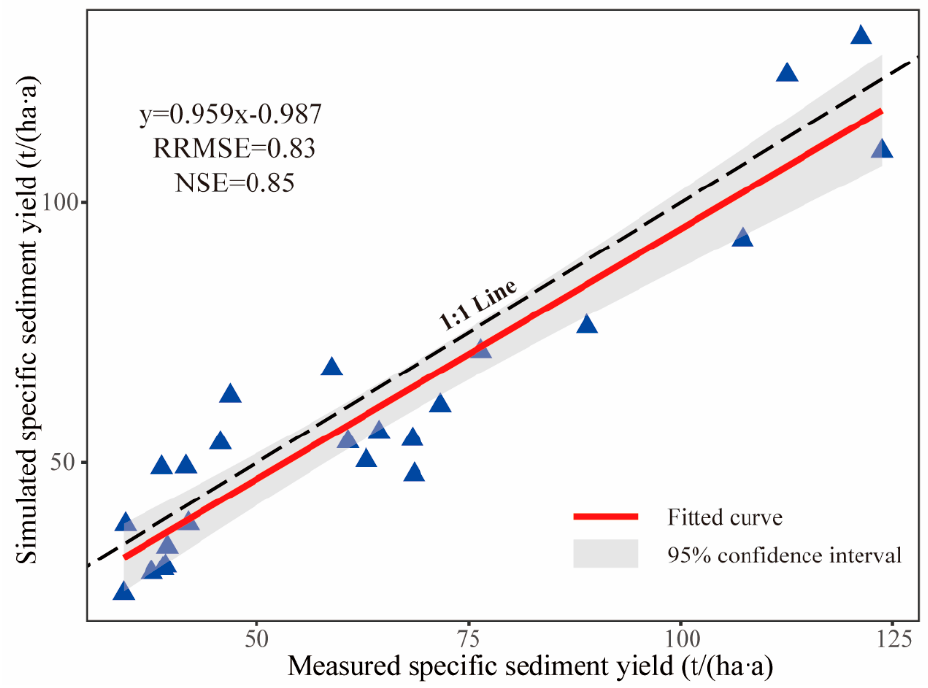
Figure 5. Comparison of the measured and simulated specific sediment yields.